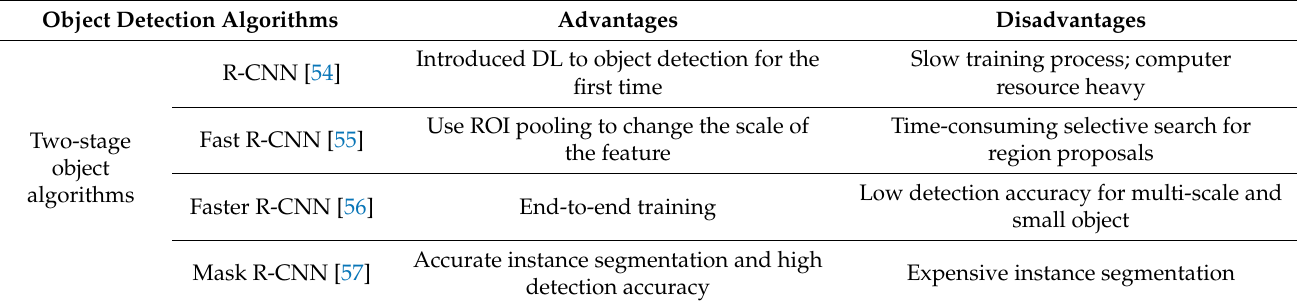
Table 2. The advantages and disadvantages of typical two-stage and one-stage object detection